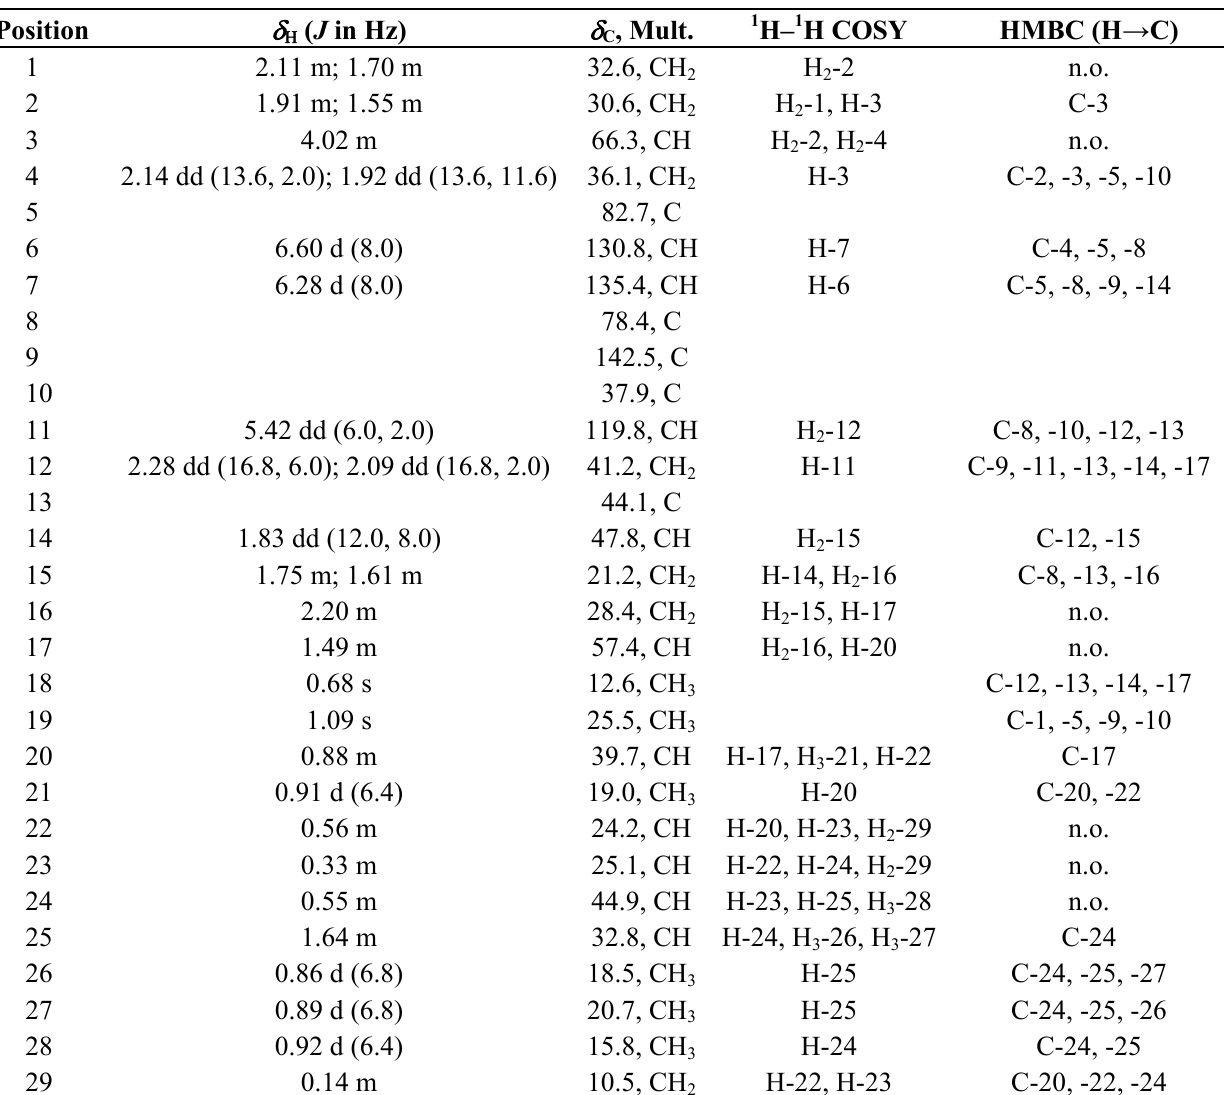
Table 1. 1 H (400 MHz, CDCl HMBC correlations for sterol 1